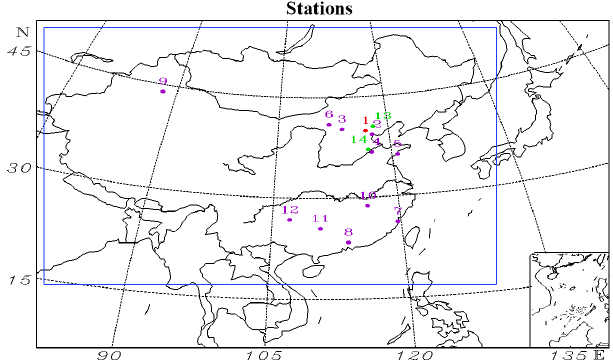
Figure 1. Geographical locations of the measurement stations in the model domain. 1: Beijing; 2: Tianjin; 3: Datong; 4: Jinan; 5: Qing- dao; 6: Hohhot; 7: Fuzhou; 8: Guangzhou; 9: Urumqi; 10: Nan- chang; 11: Guilin; 12: Guiyang; 13: Xinglong; 14: Yucheng. The different colors denote which variables are compared at each sta- tion. Purple: meteorological parameters; green: concentrations of aromatics; red: both meteorological parameters and aromatic com- pound